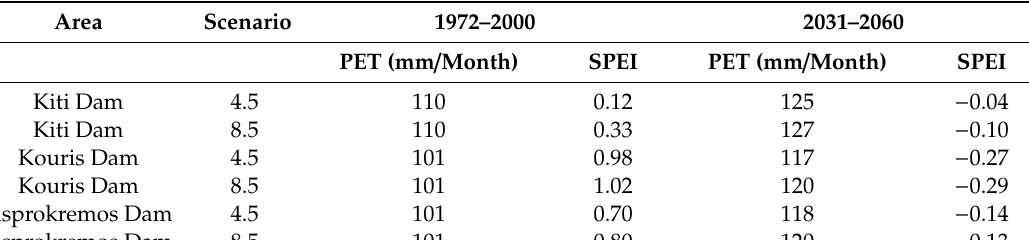
Table 4. Average PET and SPEI values in Cyprus.